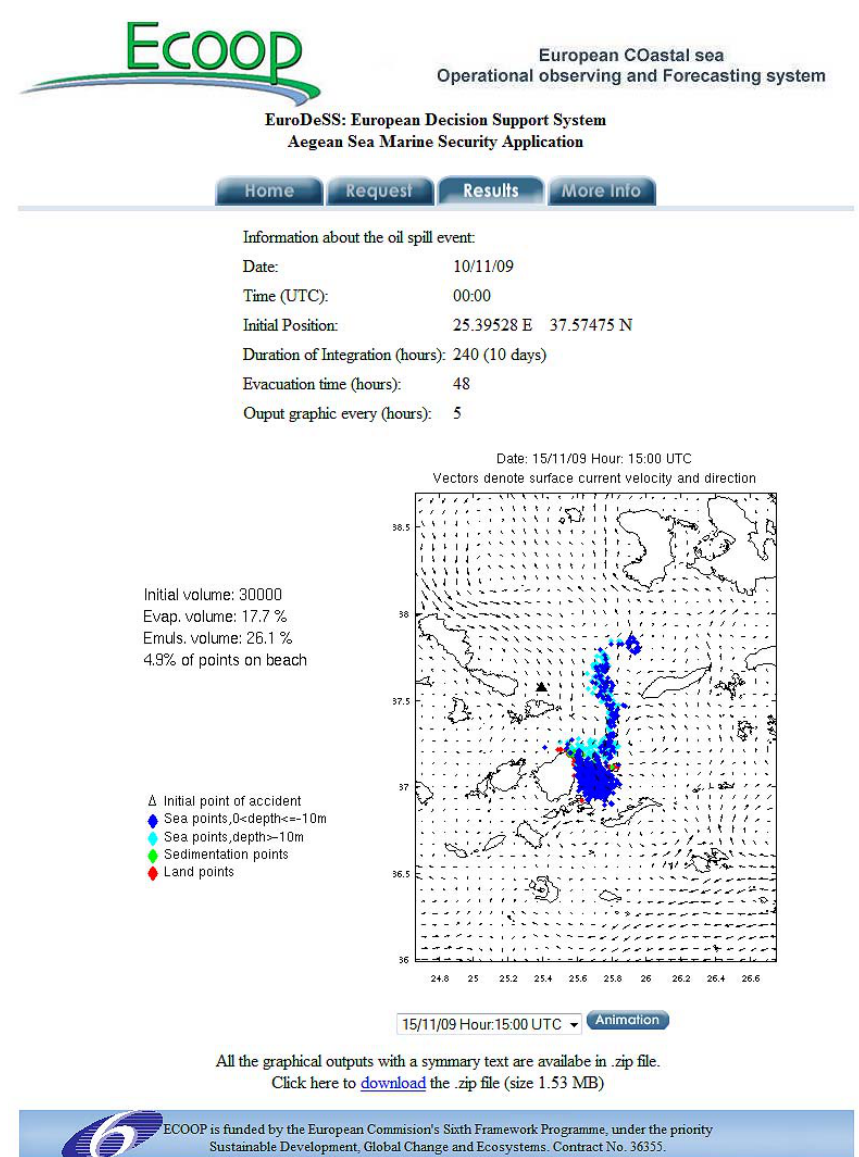
Fig. 4. The synthetic results output: the oil spill forecast is presented in graphs vs. time together with the animation option. Complementary information about the volume of the oil spill that has been evaporated, emulsificated, reached the beach or the bottom is also provided.